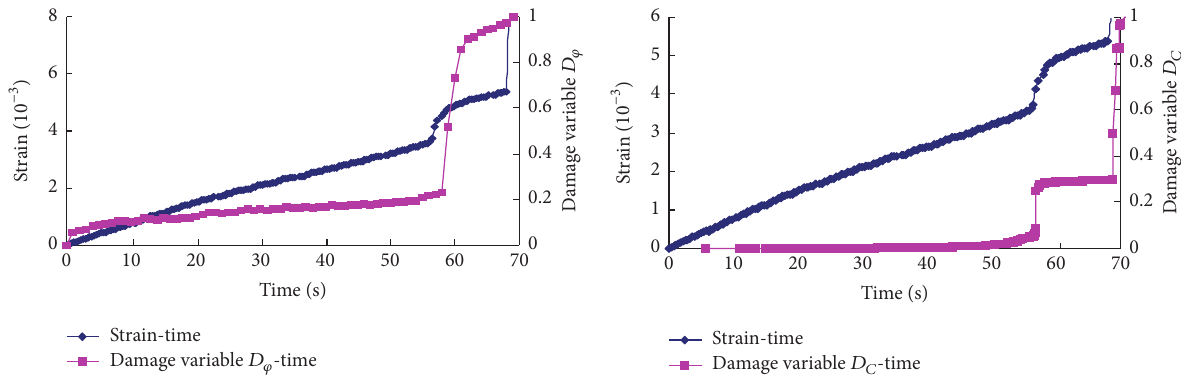
(a) Time-varying curve of the damage variable based on the electrical resistivity Figure 7: Damage variable-time curve of samples whose loading directions are parallel to the bedding